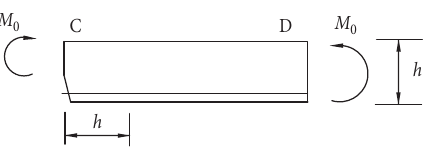
Figure 2: Free body of the beam segment.